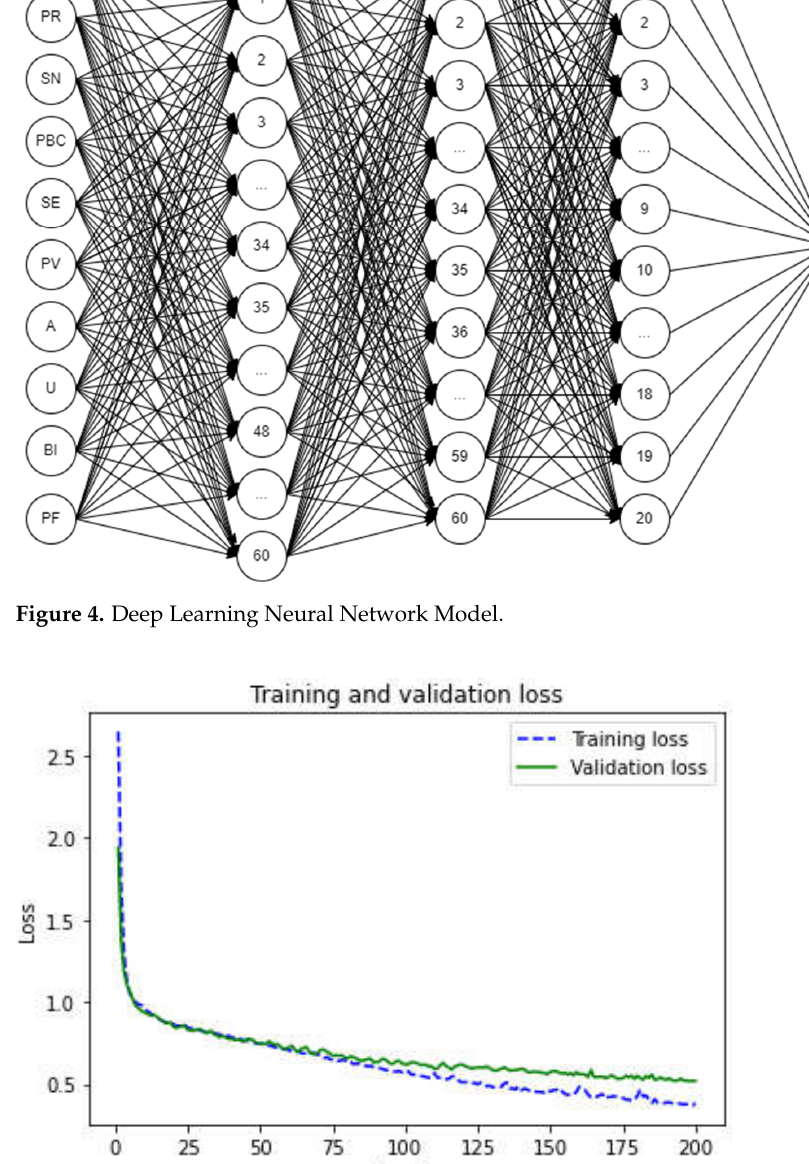
Figure 5. Training and Validation Loss Rate.